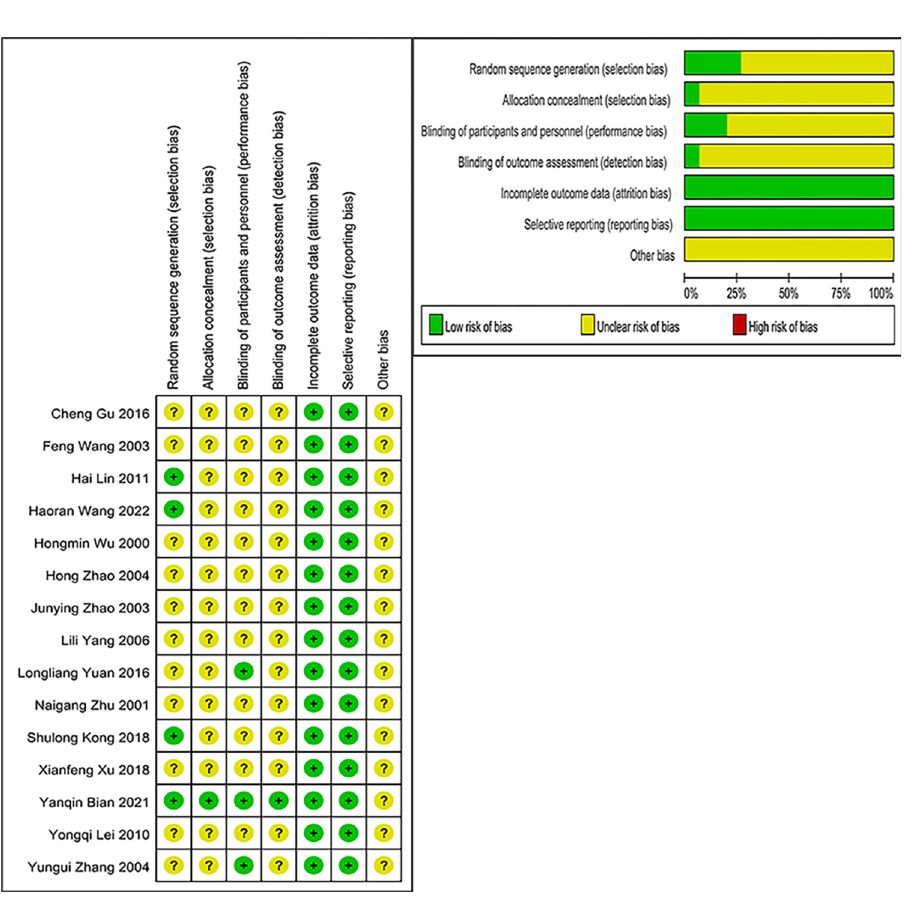
Fig 2. (a) Risk of bias summary. (b) Risk of bias